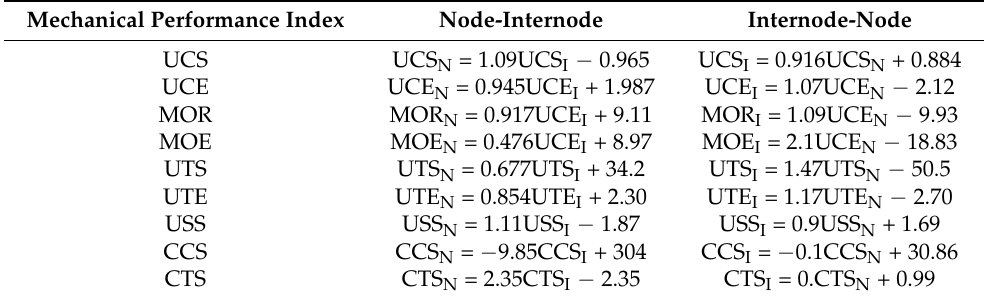
Table 4. The relationship between the mechanical properties of bamboo nodes and